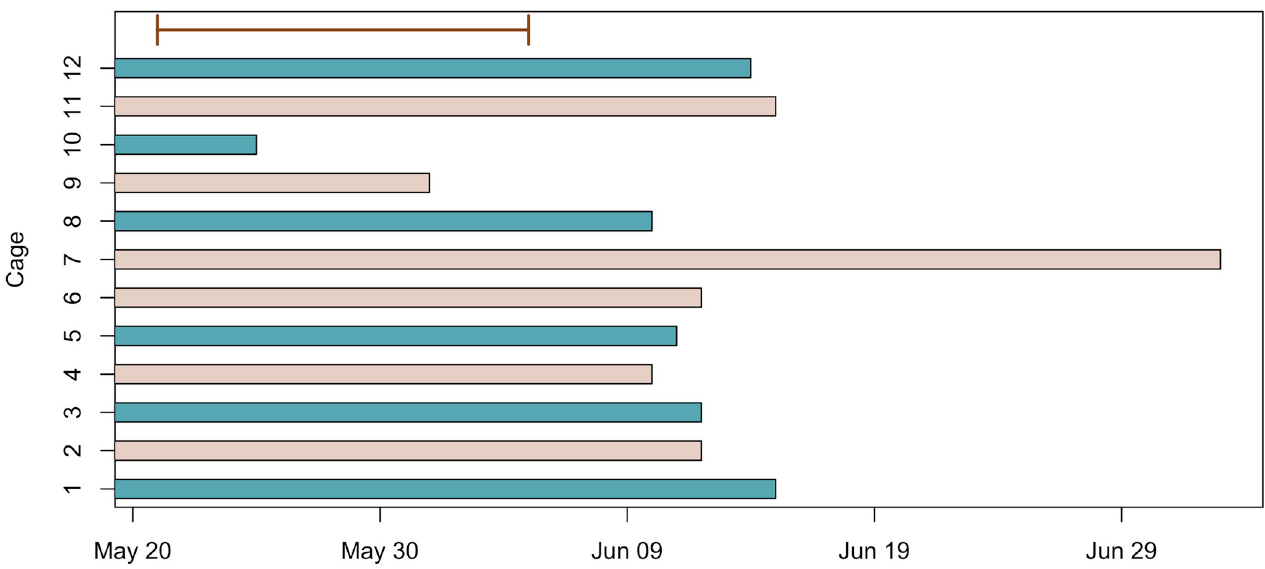
Fig 2. The bars indicate for how long bees were observed alive in each of the control (beige) and clothianidin (turquoise) cages. The brown line indicates the period, during which we observed new nest plugs appearing.